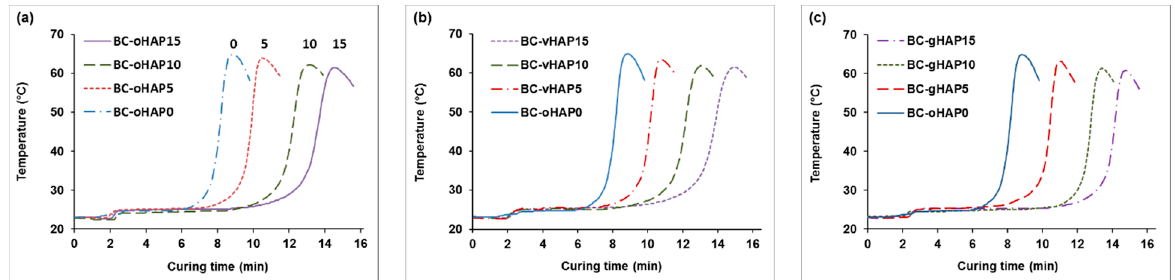
Figure 6. Curing temperature versus time of PMMA bone cements modified with 0, 5, 10, 15 wt.% of ( a ): oHAP, ( b ): vHAP, ( c ): gHAP. Table 2. Setting properties of PMMA bone cements modified with three kinds of HAPs. Loading of oHAP (wt.%) Loading of vHAP (wt.%) Loading of gHAP (wt.%) Property